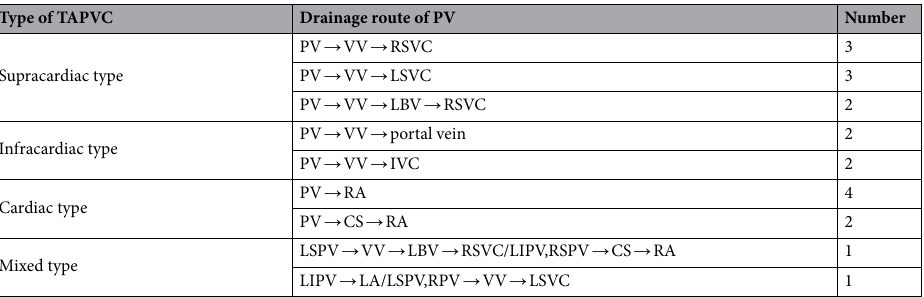
Table 2. Specific pulmonary vein drainage routes of 18 cases with confirmed fetal TAPVC. PV pulmonary vein, VV vertical vein, RSVC right superior vena cava, LSVC left superior vena cava, LBV Left brachiocephalic vein, IVC Inferior vena cava, RA right atrium, CS coronary sinus, LSPV left superior pulmonary vein, LIPV left inferior pulmonary vein, LA left atrium, RPV right pulmonary vein.